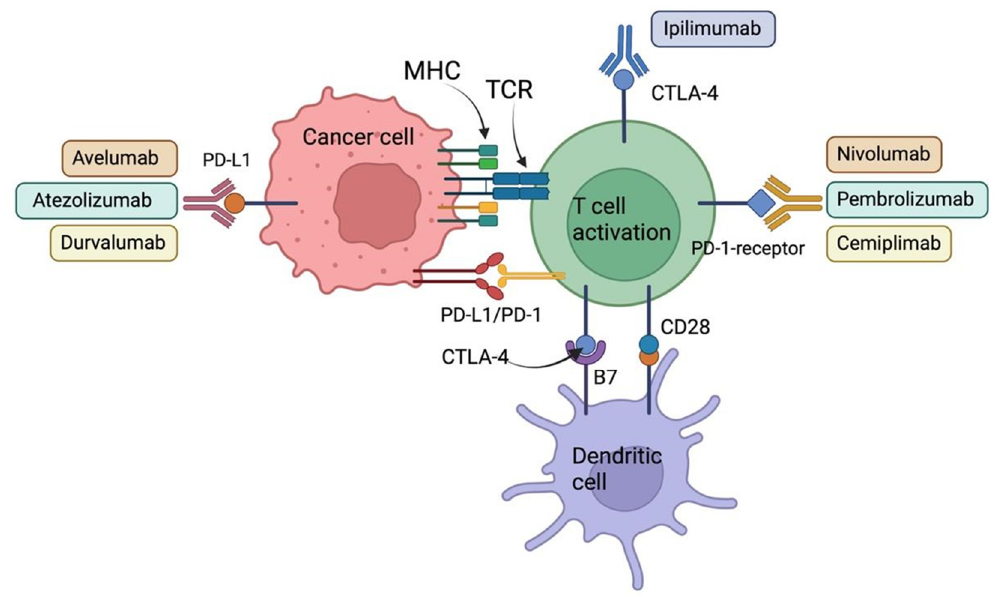
Figure 2. Immune checkpoint inhibitors (ICIs) with FDA approval. The scheme shows pembrolizumab, nivolumab, and cemiplimab (the PD-1 inhibitors); durvalumab, atezolizumab, and avelumab (the PD-L1 inhibitors); and ipilimumab (the CTLA-4 inhibitor). These antibodies are currently the most important ICI treatment options for a number of cancer types (image created with Biorender.com).